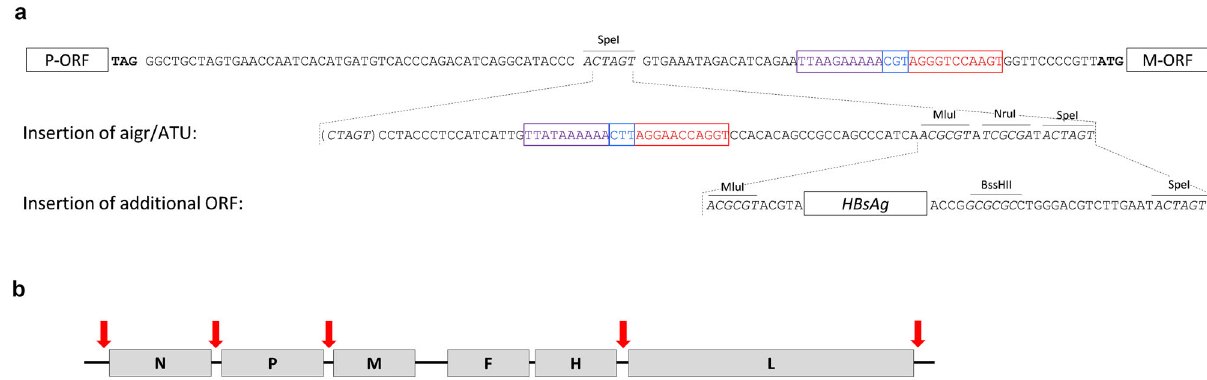
Fig. 1 Strategy to insert additional genes into MeV genomes. a Schematic depiction of the DNA Sequence of the intergenic region between P and M genes of MV NSe revealing insertion of an additional intergenic region (aigr) to be utilized as an additional transcription unit (ATU) to encode extra genes in the genome of recombinant MeV, in this example the HBsAg 30 . Shown is the sense strand of DNA sequences used for cloning. Open reading frames (ORFs) are depicted by black boxes, recognition sequences for restriction endonucleases are outlined in sequences in italics 30 and respective endonucleases are indicated. Conserved transcription termination (lilac) and re-initiation (red) sequences of the MeV polymerase separated by the non-transcribed intergenic triplet CT/GT (blue) are color coded and framed. Bold, stop and start- codons for translation of fl anking viral P and M protein ORFs. b Schematic depiction of rec. MeV genomes. Gray boxes indicated MeV ORFs, red arrows positions where ATUs have been inserted and used for the expression of additional